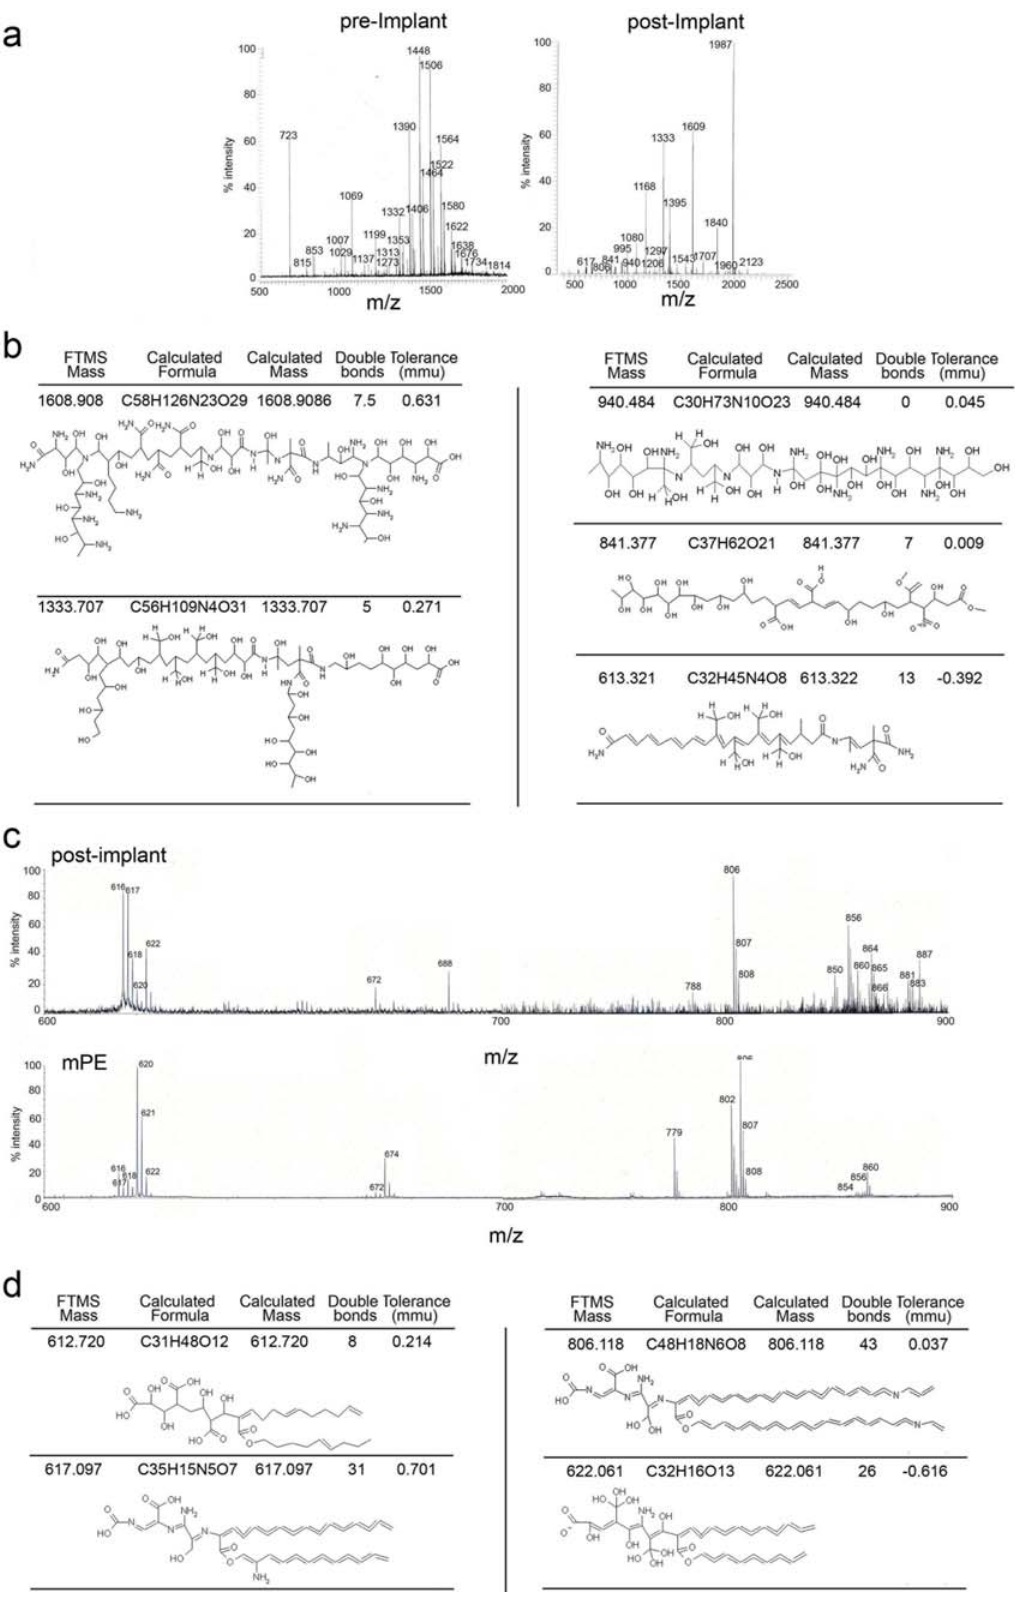
Figure 3. Mass spectroscopy analysis of n-alkane polymers purified from post implant PE indicates extensive oxidation. a) Fourier transformed FT/MS-MALDI analysis of pre and post implant PE polymers (molecular mass ranging between 400 and 2000). b) Predicted chemical composition for major peaks of post implant PE derived from FT-MS analysis depicted in a. c) MALDI-TOF scan (600–900 m/z) of PE purified from post-implant PE and mPE. d) Predicted chemical composition for major peaks of mPE and post implant PE depicted in c .